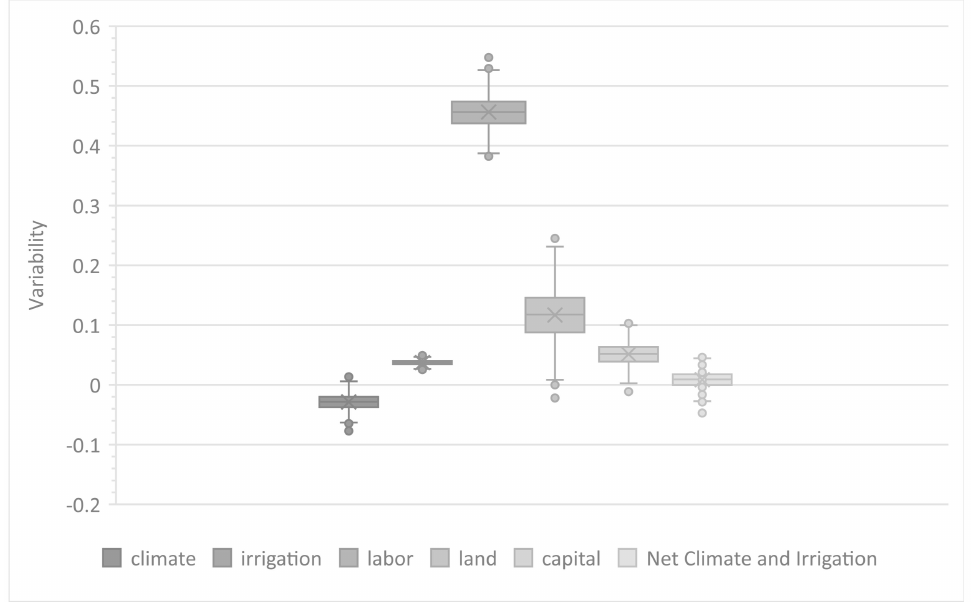
Figure 3. Comparison of climatic variability against other contributors to agricultural productivity in the southern US (from model TFE c in Table 3), using a Monte Carlo simulation with 1000